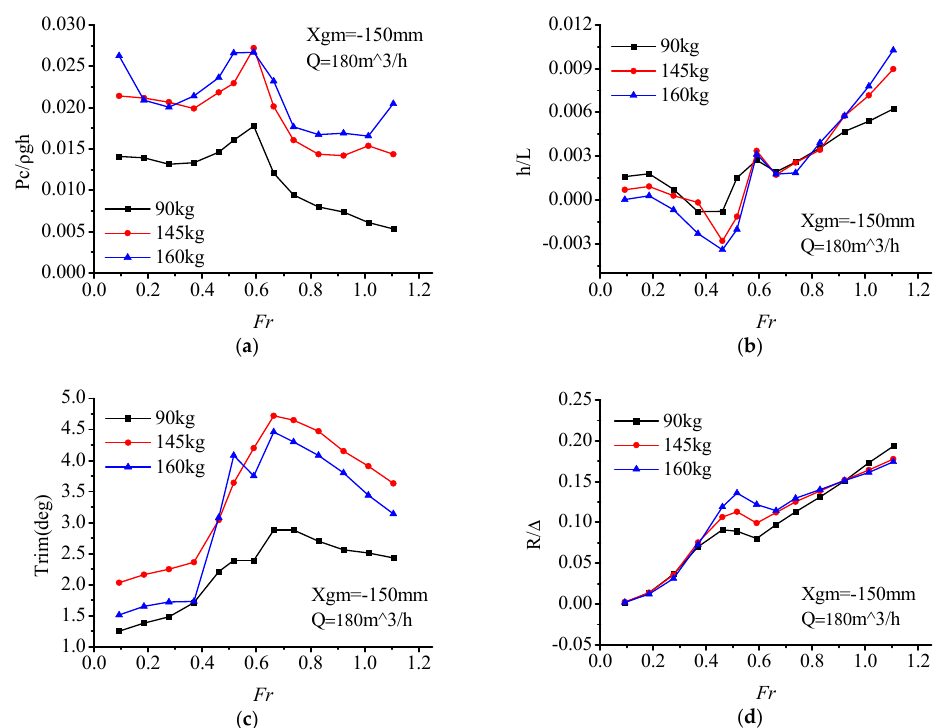
Figure A4. Comparisons of numerical and experimental results with consistent airflow Q = 180 m 3 /h. ( a ) Curves of air cushion pressure; ( b ) Curves of air cushion heave; ( c ) Curves of trim angle; ( d ) Curves of total resistance.